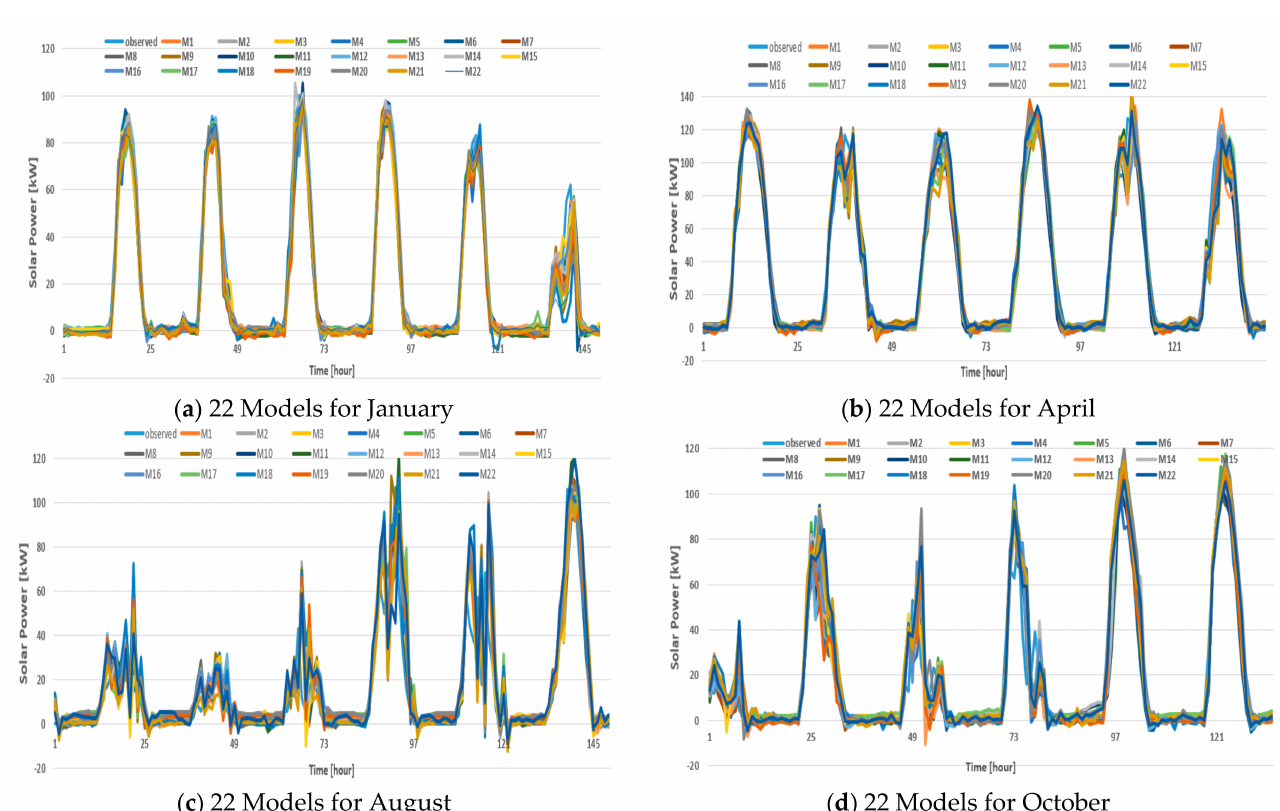
Figure 9. Comparison among the 22 models for the traditional LSTM by